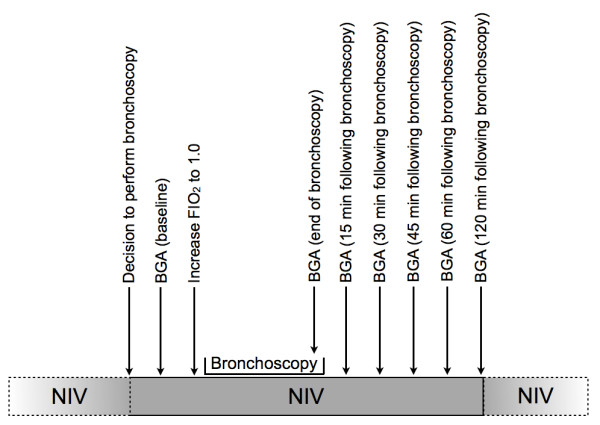
Design of the study. NIV, noninvasive ventilation; FiO2, fraction of inspired oxygen.